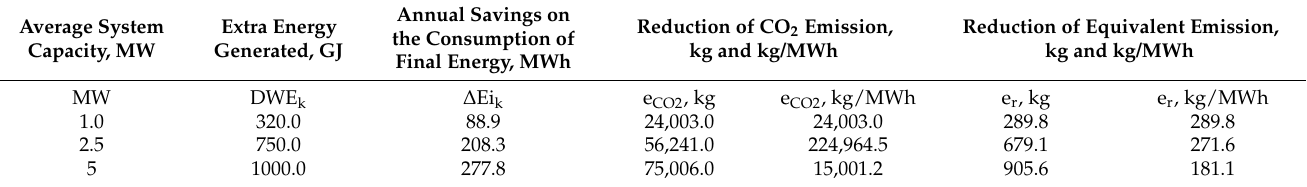
Table 4. The ecological effect as a reduction of CO 2 emission and equivalent emission due to the